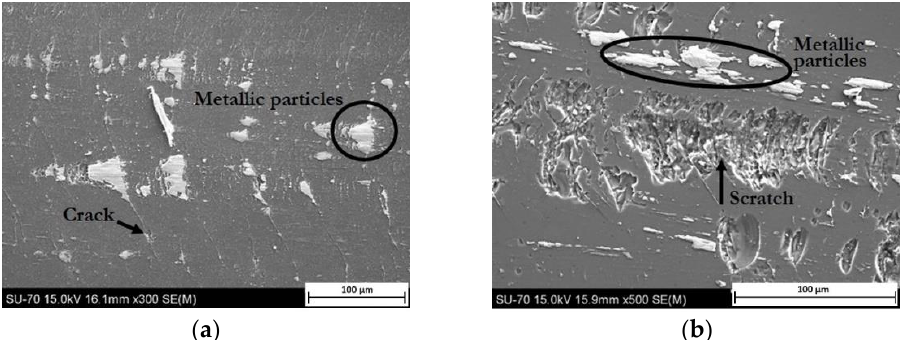
Figure 4. SEM images from glaze surfaces ( a ) earthenware plate after metal marking test (deposition of metallic particles in the cracks); ( b ) extensively used porcelain plate (deep scratches and metal marks resulting from normal use are presented).